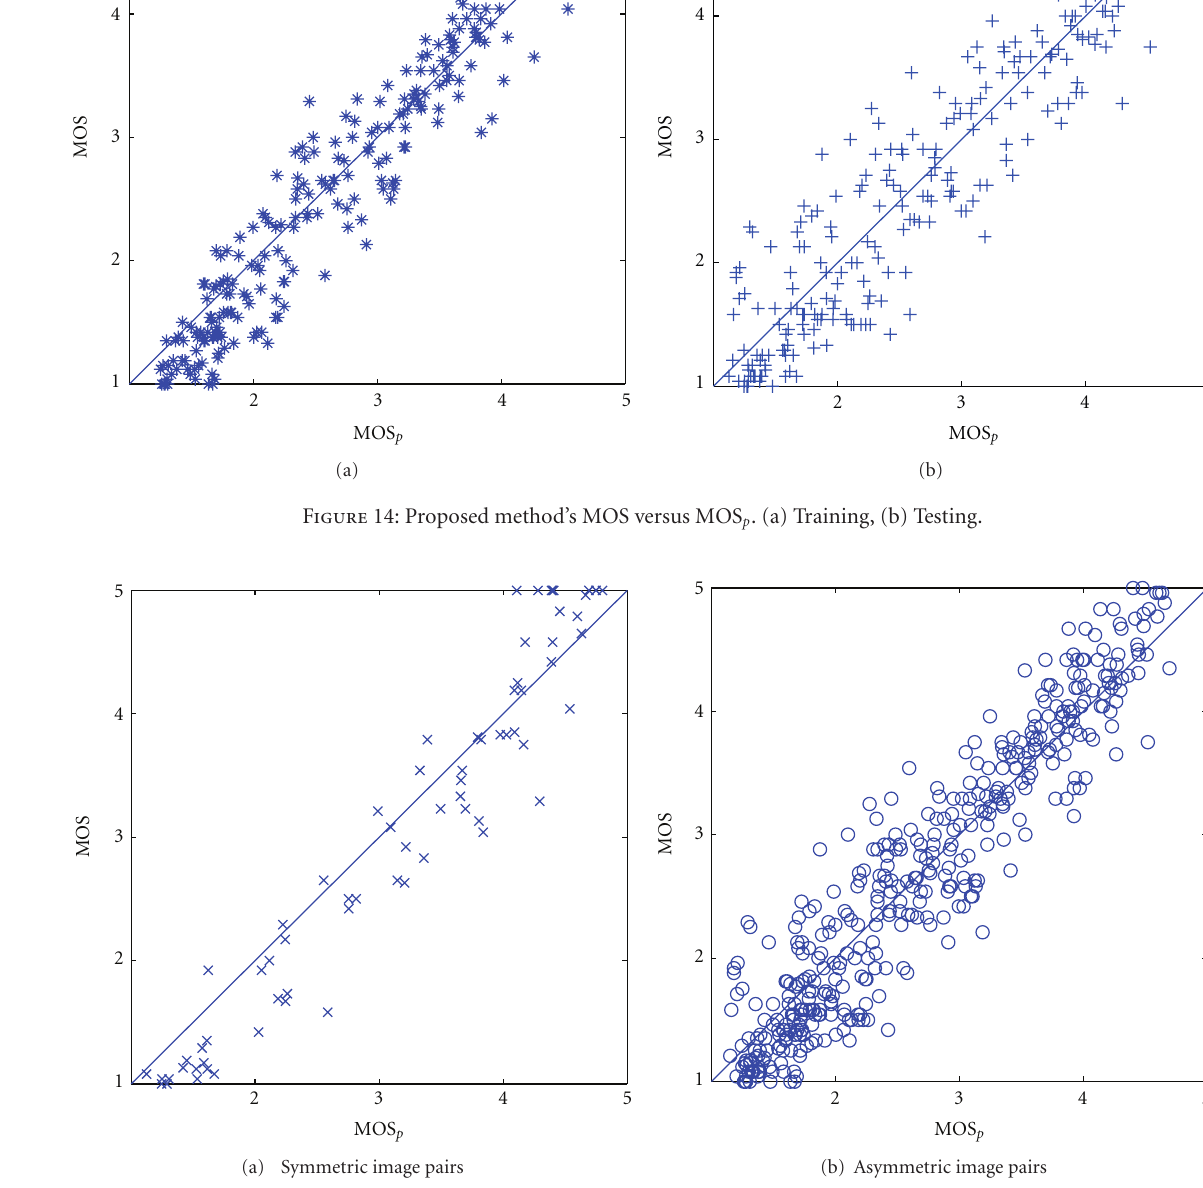
Figure 15: Proposed method’s MOS versus MOS p for symmetric and asymmetric coded